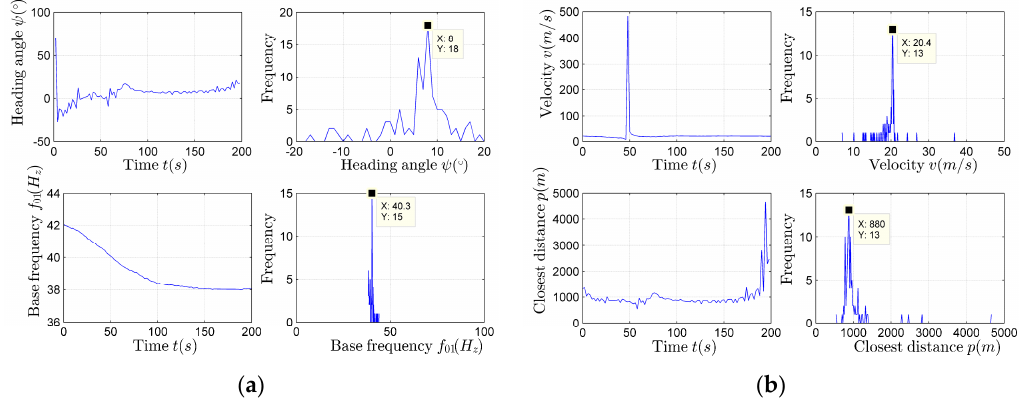
Figure 7. The distribution diagram and statistical histogram of the aerial target motion parameters in the horizontal direction. ( a ) The estimation results of the heading angle and the base frequency; ( b ) The estimation results of the velocity and the closest distance. Table 2. The parameter estimation results in the horizontal direction.